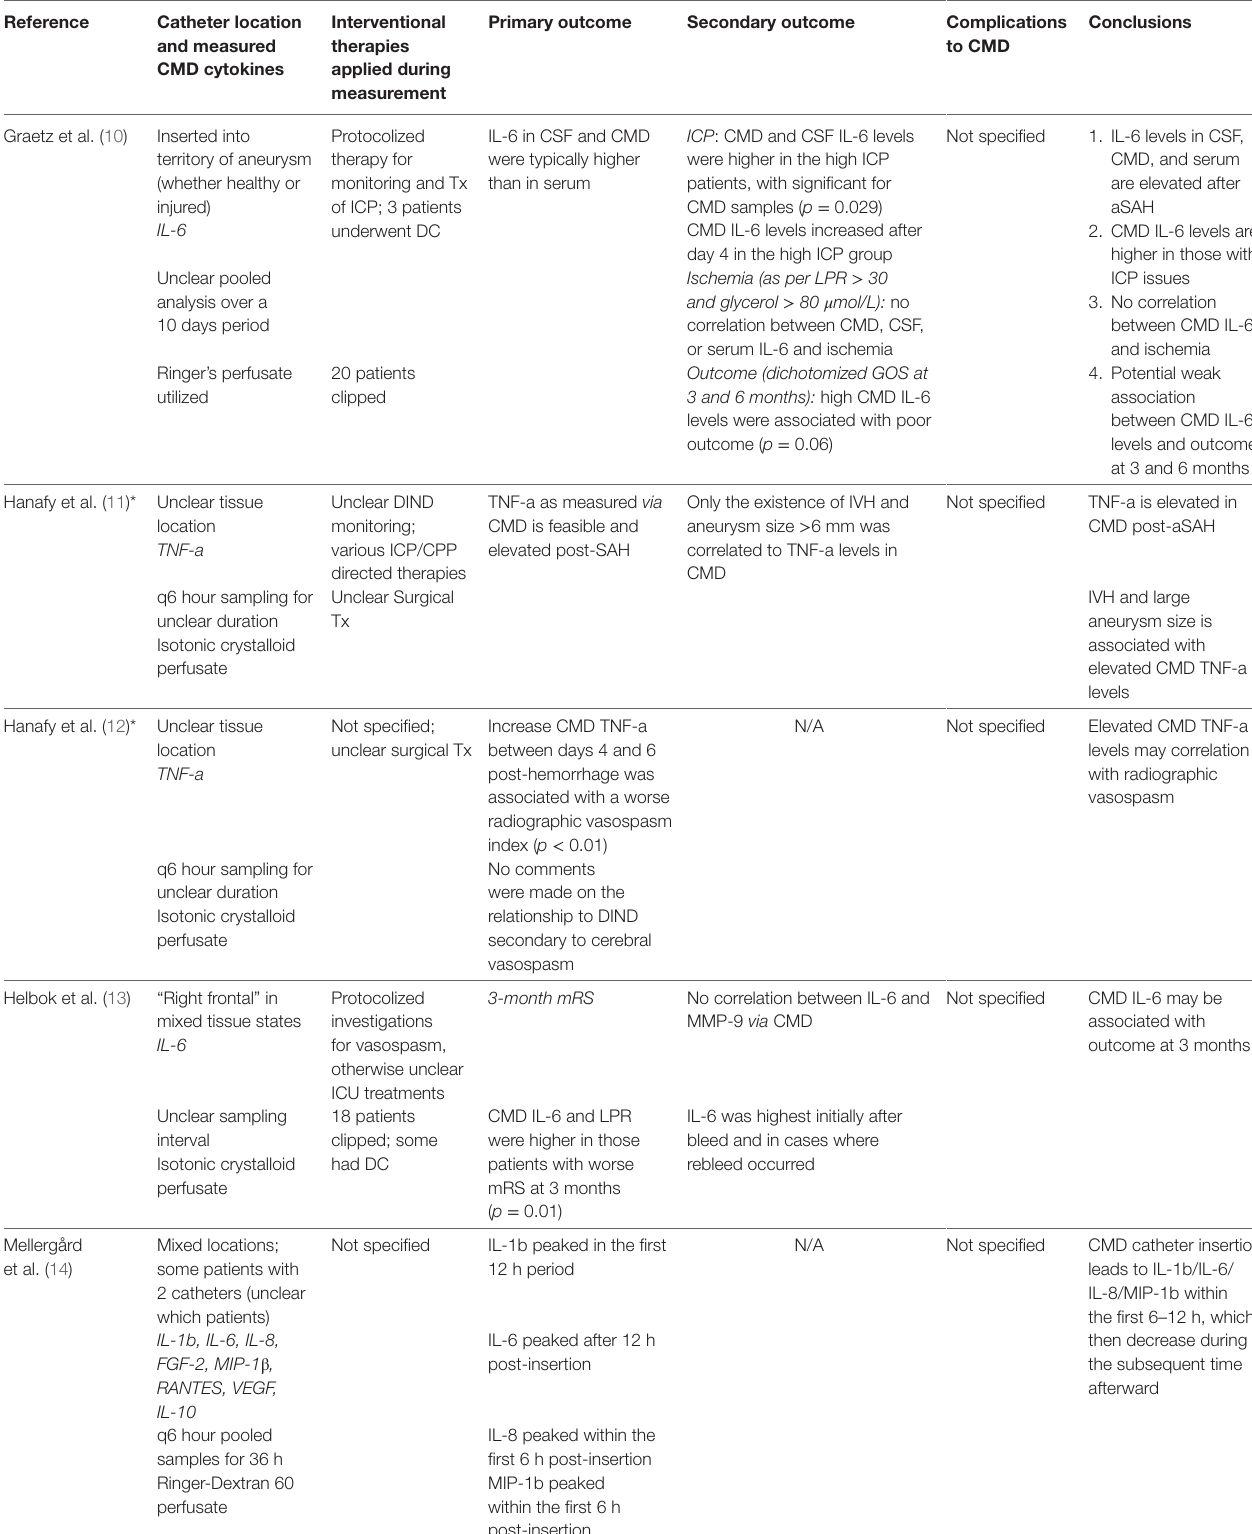
TABLe 3 | CMD cytokine measures and